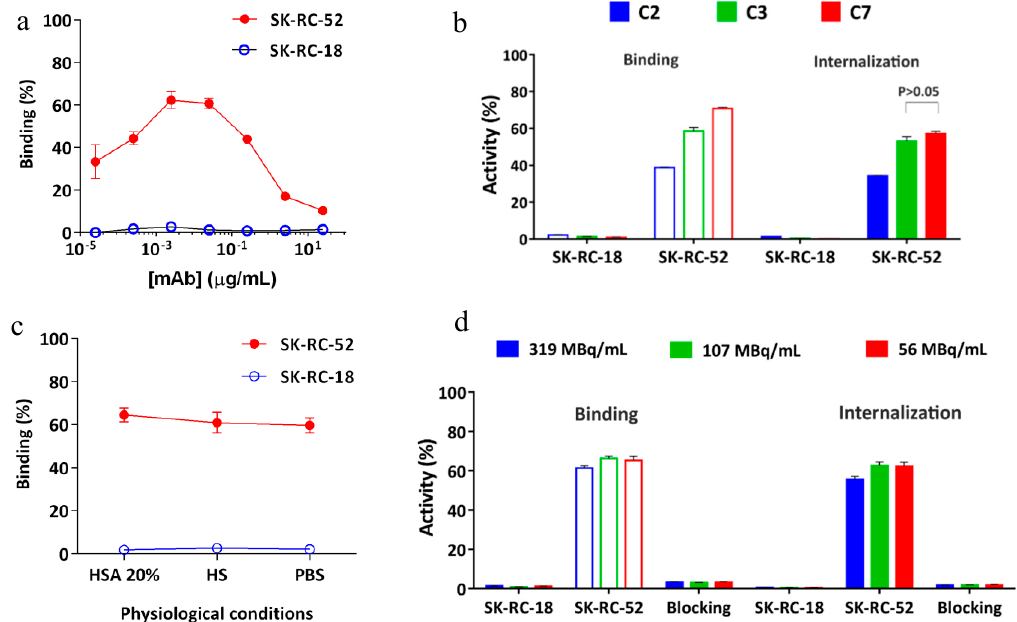
Figure 5. Radioimmunoactivity in vitro of [ 177 Lu]DOTA(SCN)-cG250 to SK-RC-52 cells ( n = 3). ( a ) Concentration-dependent binding of [ 177 Lu]DOTA(SCN)-cG250 using the conjugate C3 (60 min). ( b ) Recognition of radioconstructs from conjugates C2 (90 min), C3 (60 min) and C7 (30 min) to SK-RC-52 cells by radioimmunoassay at 2 MBq/ µ g specific activity. ( c ) Radioimmunoactivity in HSA 20%, HS and PBS at 2 MBq/ µ g specific activity using the conjugate C3. ( d ) Radioimmunoactivity of [ 177 Lu]DOTA(SCN)-cG250 at different activity concentrations using the conjugate C3. Blocking studies were performed with 50 µ g of native cG250.